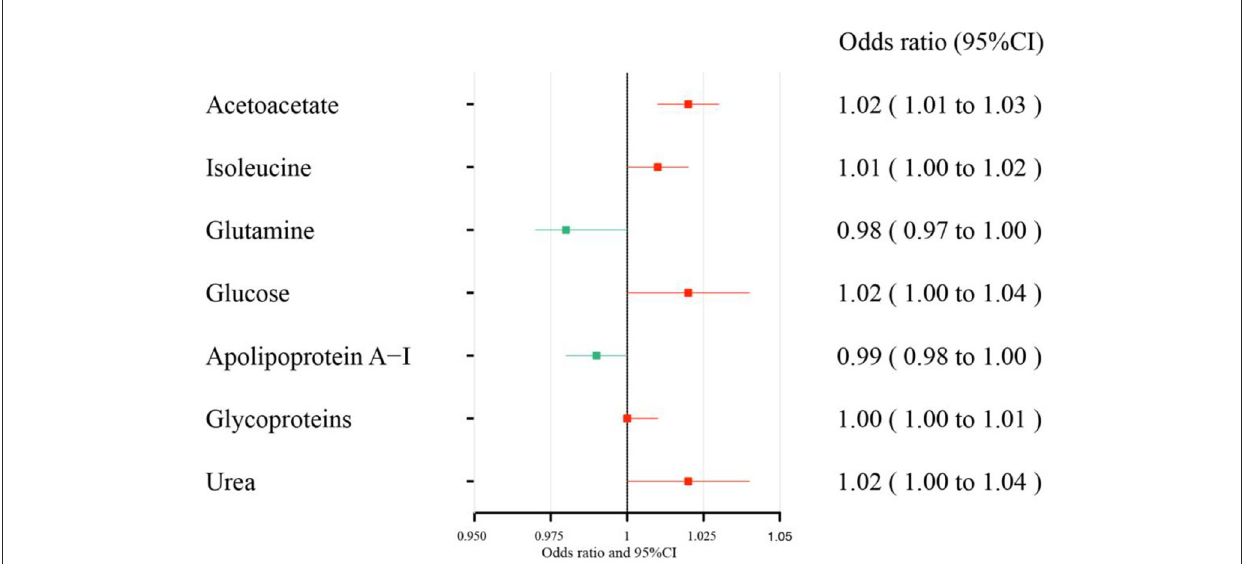
FIGURE3 Effect size of each metabolite on depression. There is a protective causal effect when the OR value is < 1, whereas a causal pathogenic impact appears when the value is > 1. Through the IVW and weighted median analysis, the results were generated.